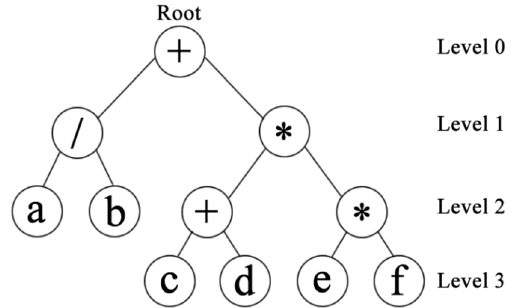
Figure 9. Expression tree schematic.